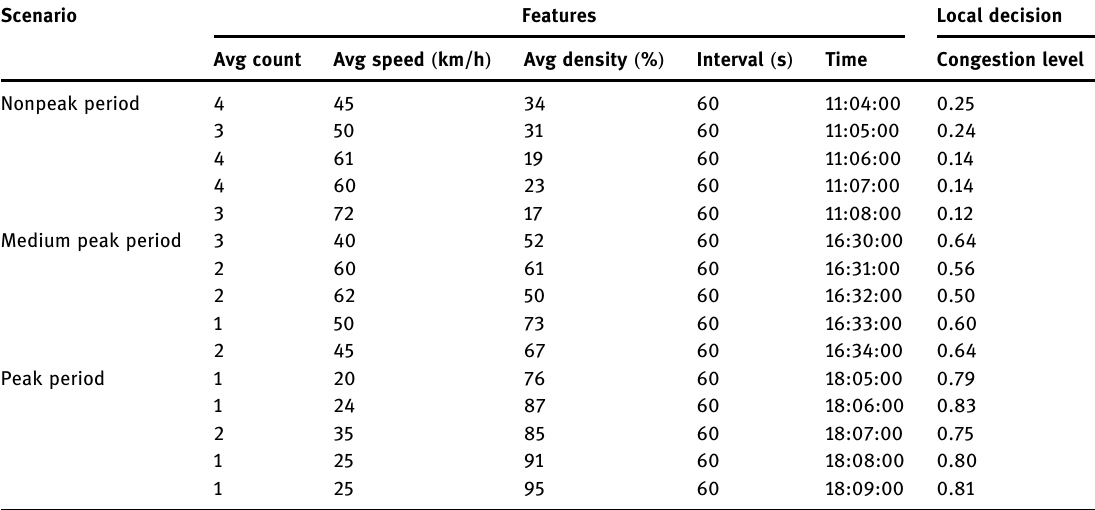
Table 6: DF results at S904